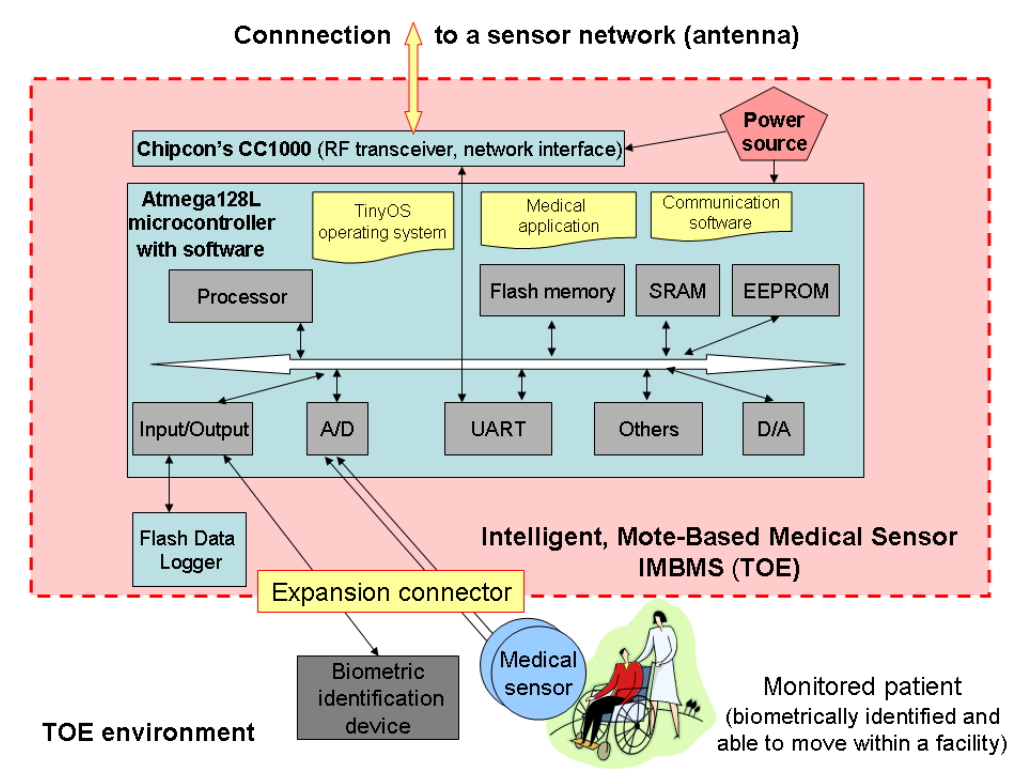
Figure 3. IMBMS—Intelligent Mote-Based Medical Sensor as the